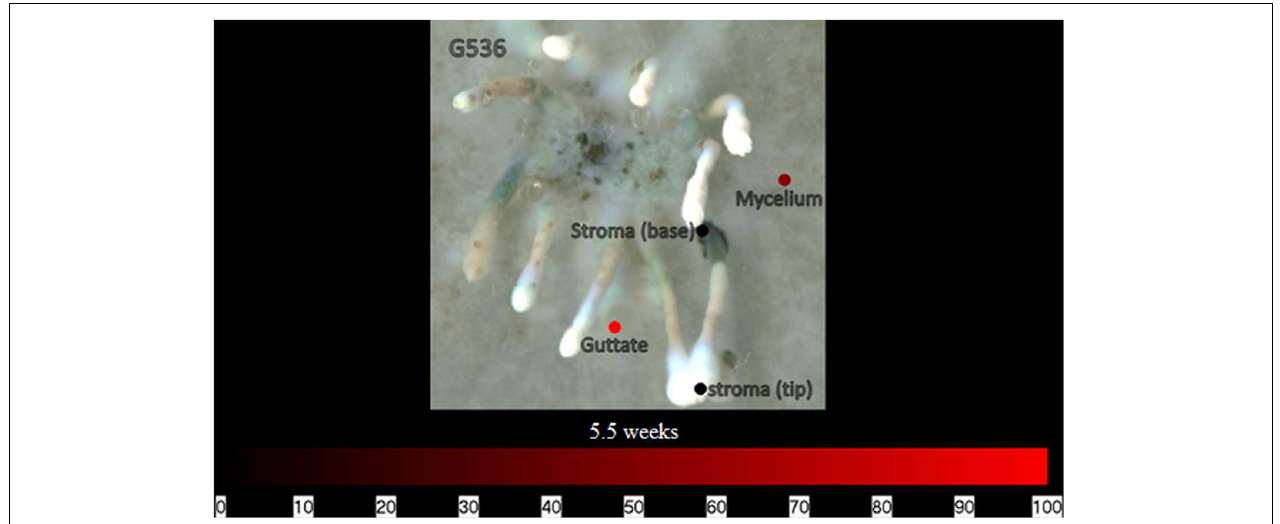
FIGURE 10 | The spatial distribution indicating the relative intensities of griseofulvin on fungal culture X. cubensis (G536) for the stroma, mycelium, and guttates at 5.5 weeks. Each circle represents a sampled location. Griseofulvin was most intense where the circles are bright red. The bottom bar indicates the relative amount of signal as measured via mass